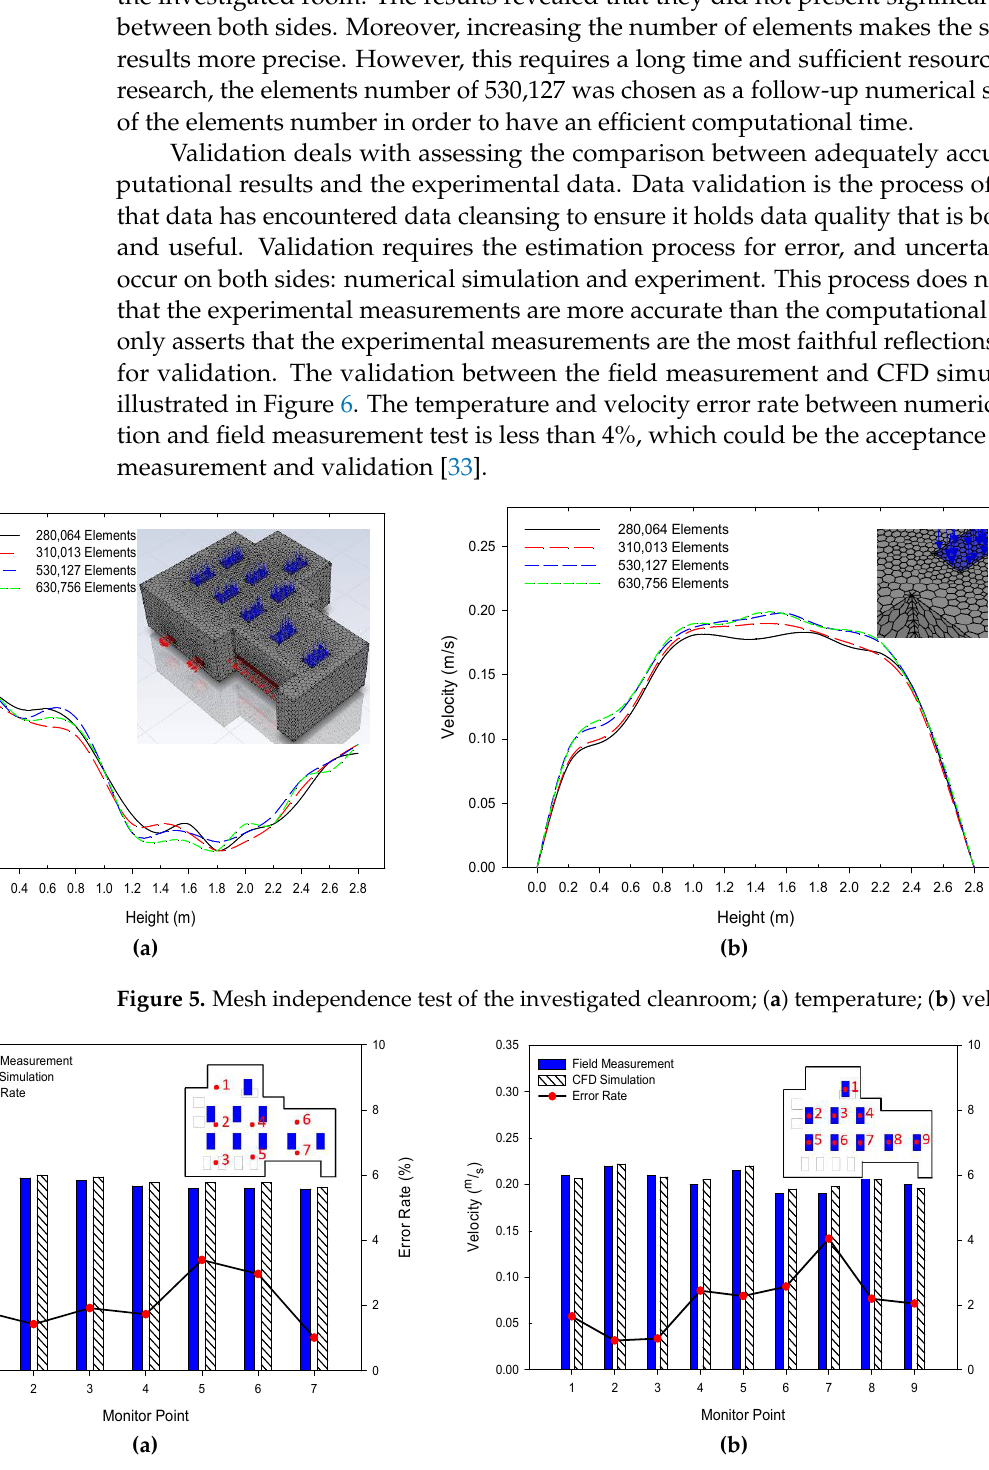
Figure 6. Validation; ( a ) error rate temperature results; ( b ) error rate velocity results.